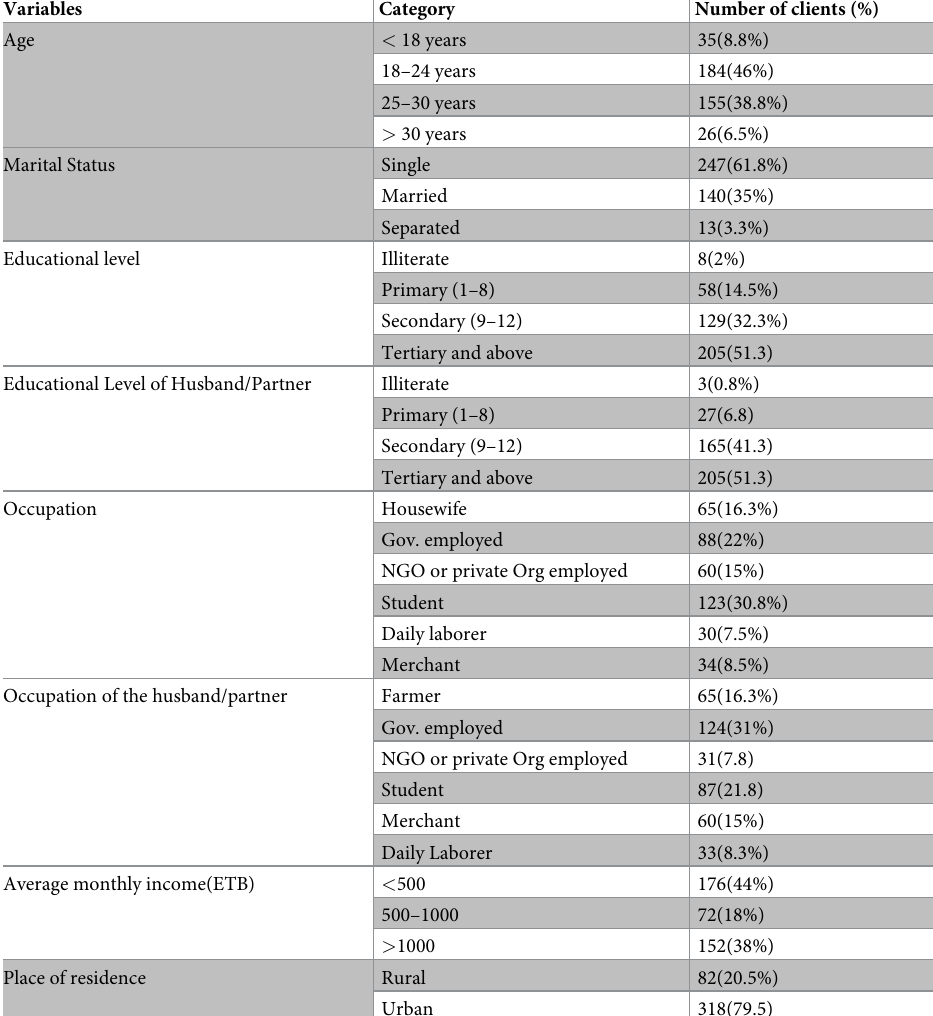
Table 1. Socio-demographic and economic characteristics of post-abortion clients, Wolaita Sodo, 2019.